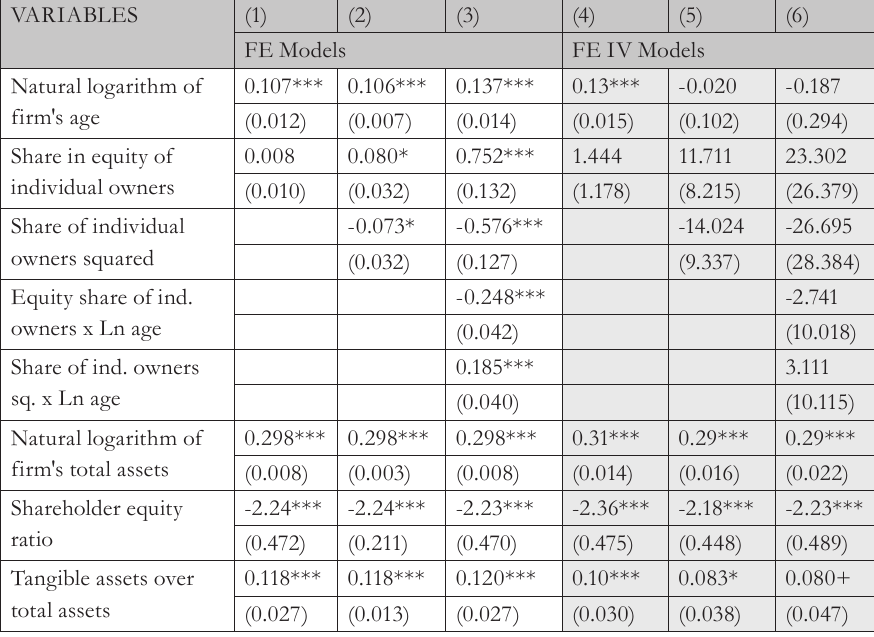
Tab. 2 – Fixed effects models. Dependent variable: Total Factor Productivity. Source: